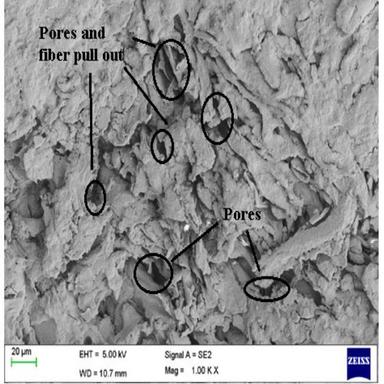
Pores and the fiber pull-out in SEM of Citrus limetta peel powder composites.